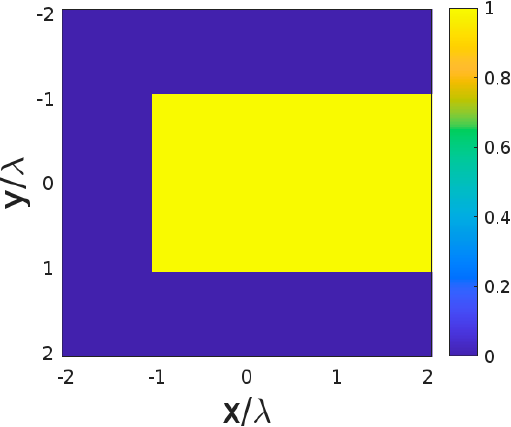
Figure 16. The geometry of the dielectric object in ID.